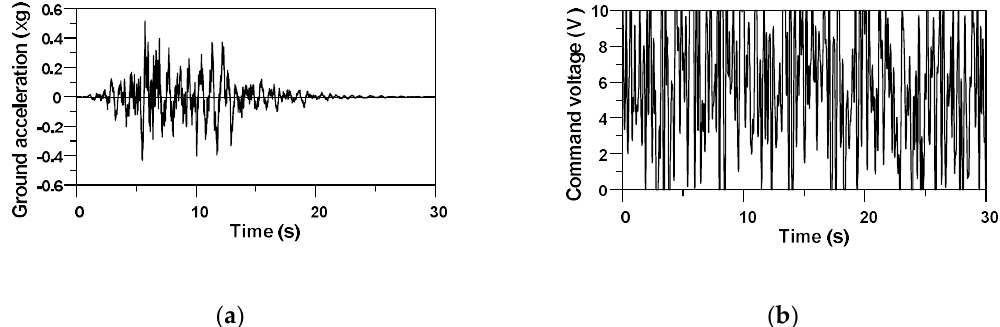
Figure 6. Time histories of input data for RNN: ( a ) Ground acceleration time history of artificial earthquake 1 (EQ No. 6); ( b ) Command voltage time history.